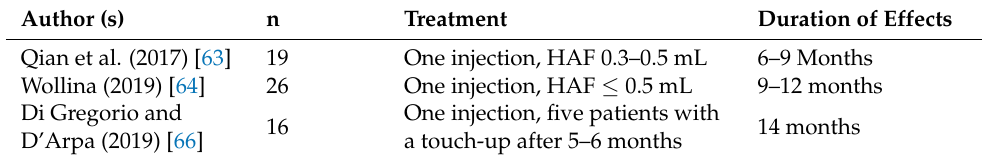
Table 5. Effect of HAF on earlobe ptosis Mowlavi grade I and II